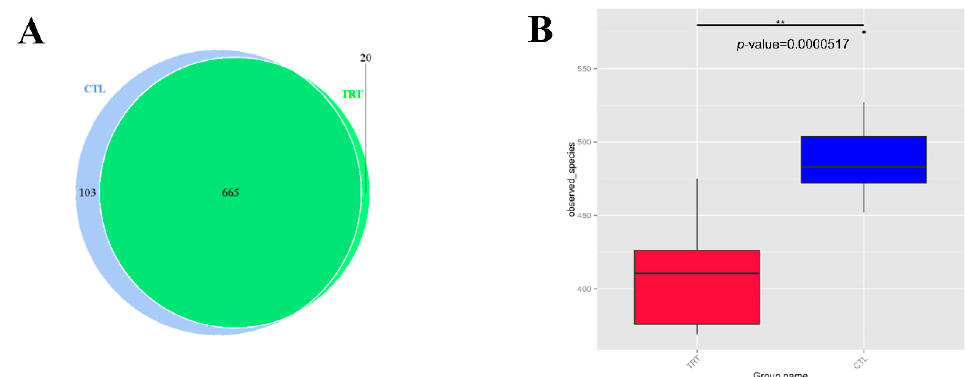
Figure 1. Dietary silymarin supplementation modulated microbiota diversity in lactation sow. ( A ) A Venn diagram was generated to describe the common and unique OTUs between the treatment groups. ( B ) The effect of silymarin on the observed species. CTL, sow fed the basal diet; TRT, sow fed basal diet with silymarin 40 g/d from late gestation to lactation. ** are significantly different ( p < 0.01).